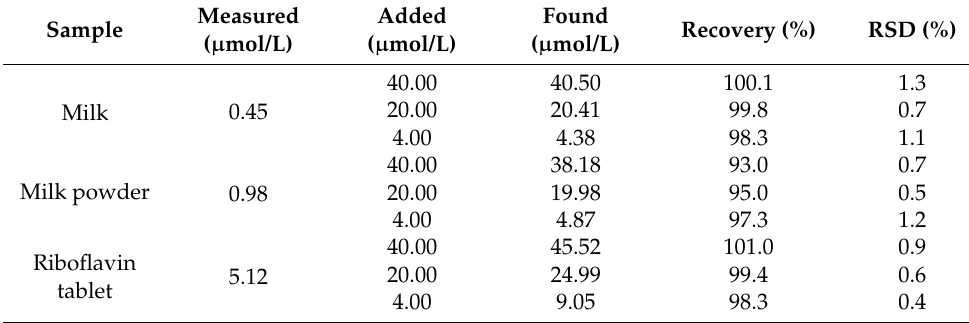
Table 2. Detection of riboflavin in real samples with the proposed